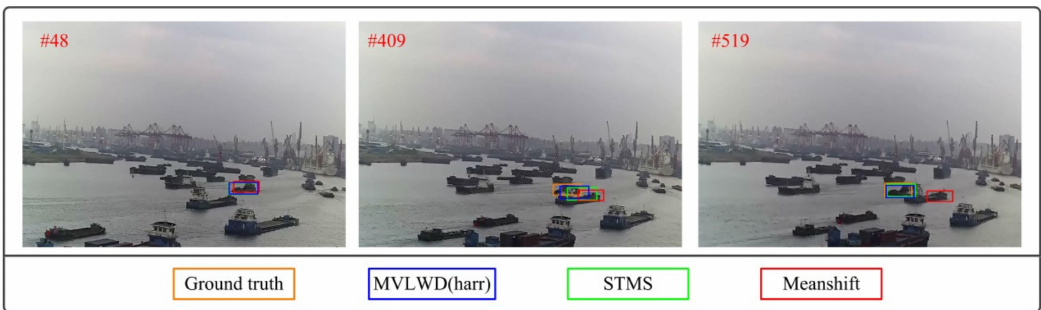
Figure 3. Euclidean distance distribution for the three trackers on video #1.